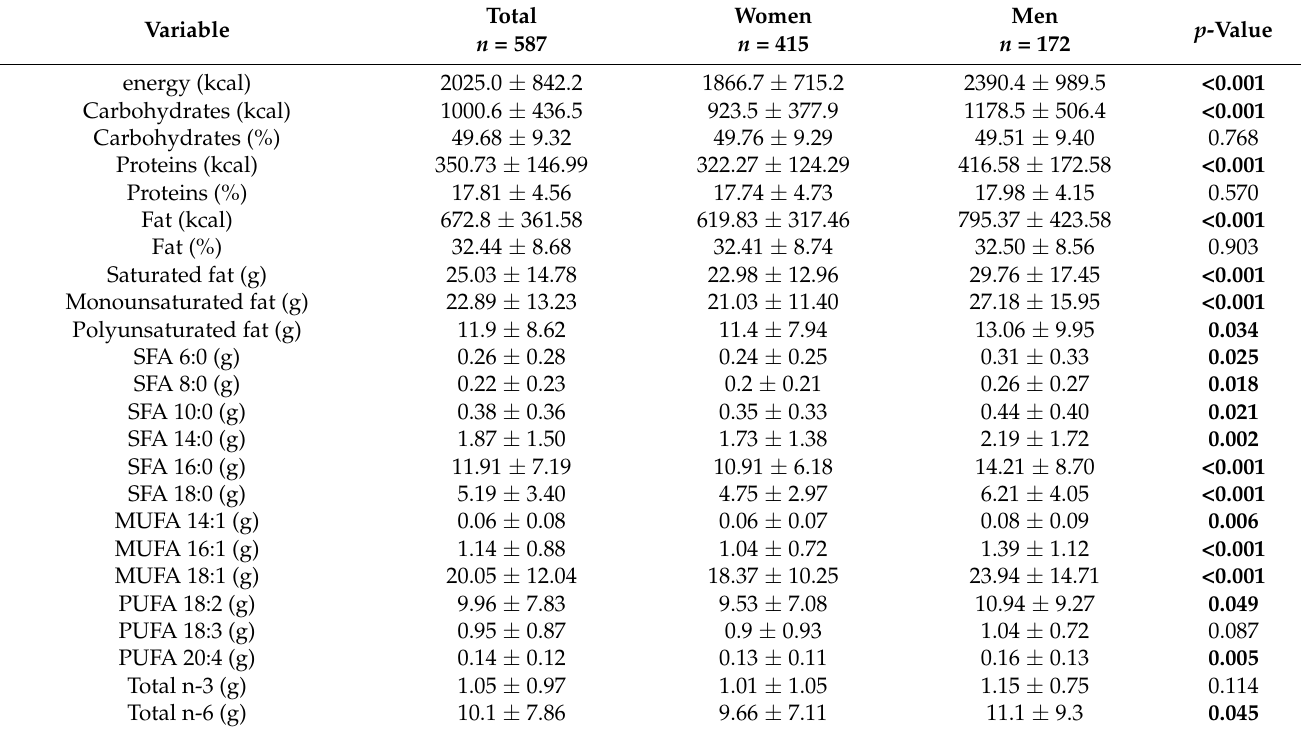
Table 2. Nutritional characteristics of the study